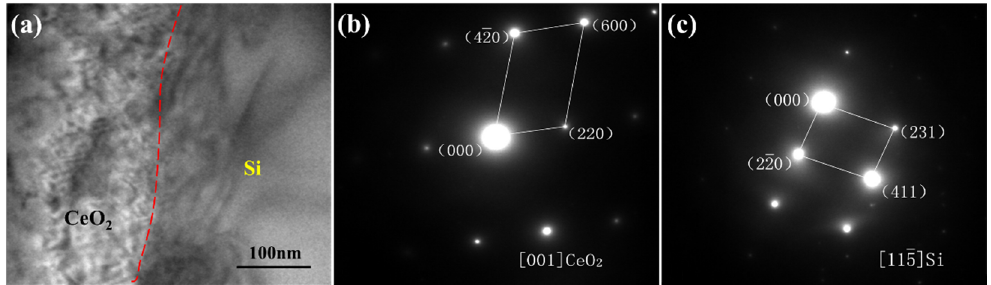
Figure 5. TEM observation of SiCp/Al-Si composites with 0.6 wt% CeO 2 content: ( a ) CeO 2 -Si interface; ( b ) Diffraction patterns of the CeO 2 ; ( c ) Diffraction patterns of the precipitated Si.